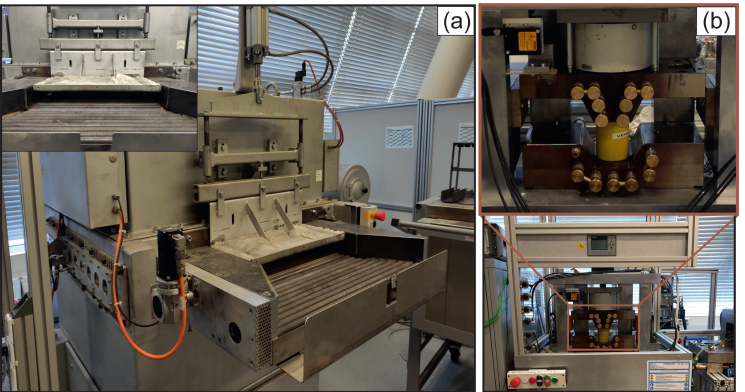
Figure 1. ( a ) Roller hearth furnace and ( b ) forming tool used for sample production [5].